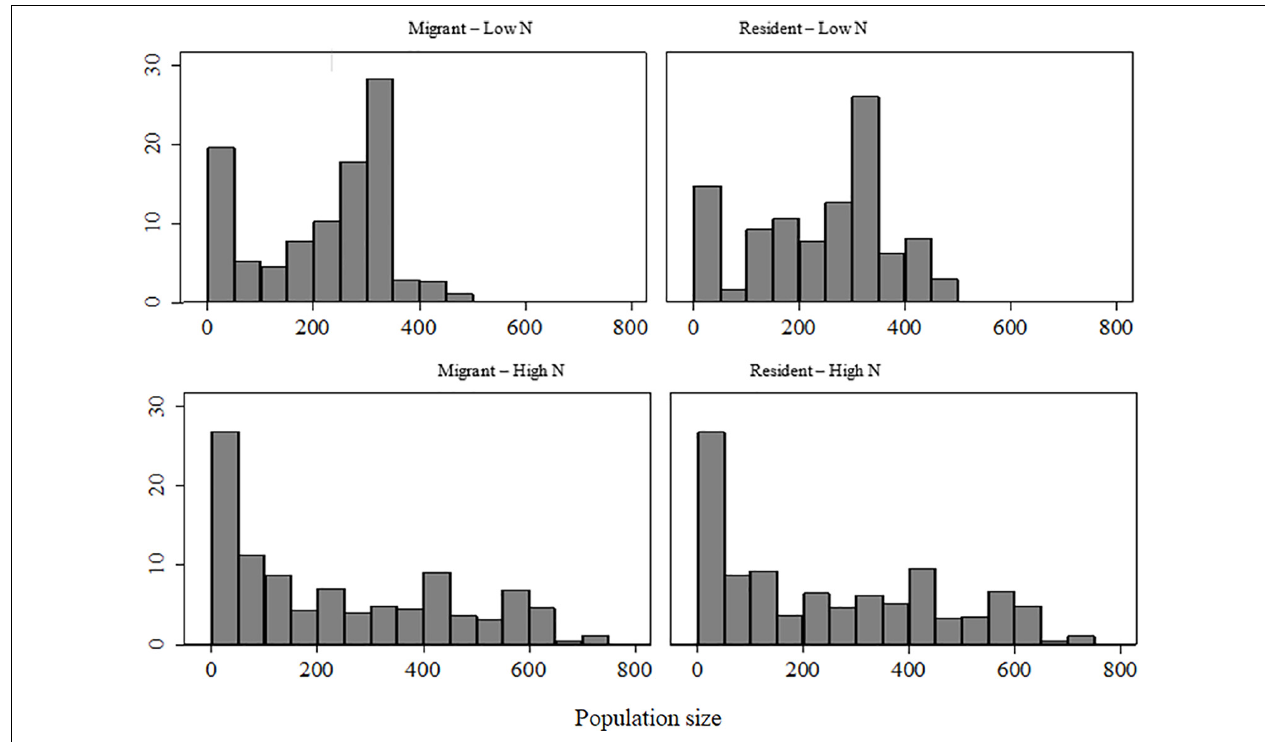
FIGURE 5 | Percent frequency of observed group sizes associated with migrant and resident elk recorded during winters of high ( > 600) and low ( < 600) elk population size on the Ya Ha Tinda winter range adjacent to Banff National Park, Alberta, Canada. Population size (N) was determined from aerial surveys. Supplementary Table S1 provides population sizes.